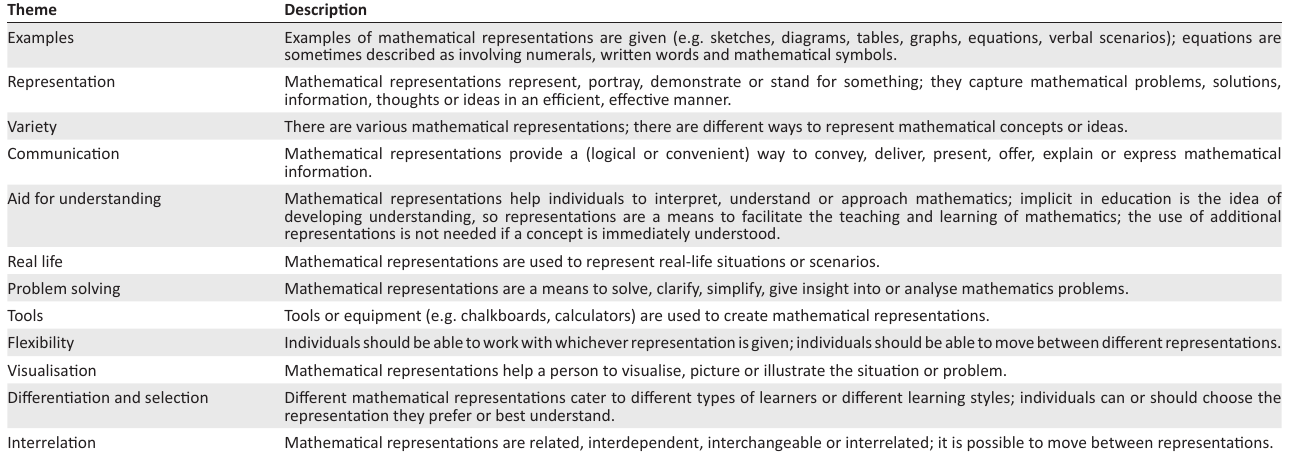
TABLE 1: Themes for mathematical representations.